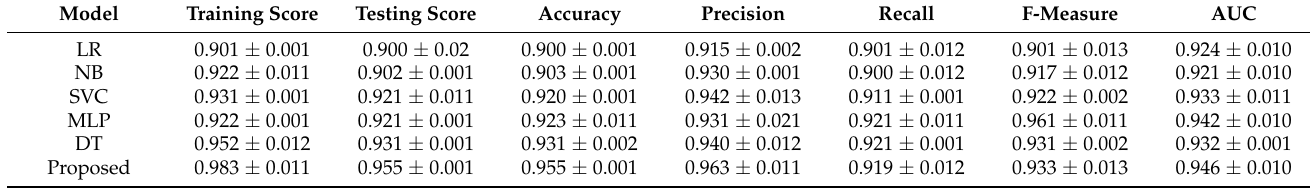
Table 1. Results for CTS diagnosis.